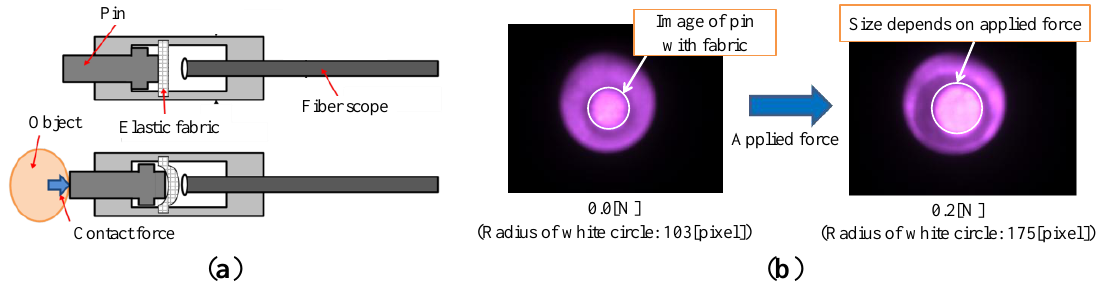
Figure 2. ( a ) Schematic structure of force visualization part. ( b ) Captured image of pin (with elastic fabric).